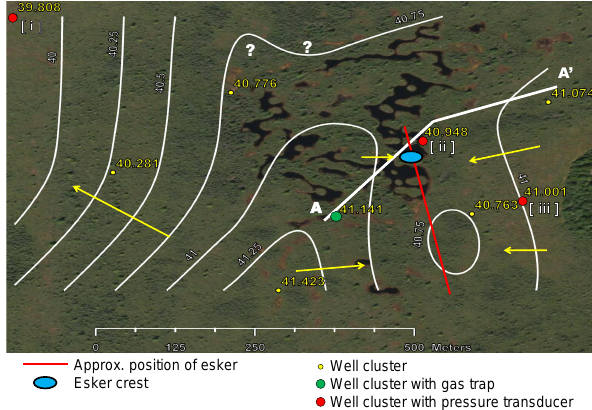
Fig. 10. Central unit enlarged showing the positions of 9 well clus- ters and the relative position of the esker and esker crest (Comas et al., 2011). Groundwater flow in the central unit is based off wa- ter level readings from 3m wells on 5 November 2011. White line, A–A 0 , refers to cross sections in Fig. 11. There is an area of lower 8 hydraulic head above the esker driving convergent